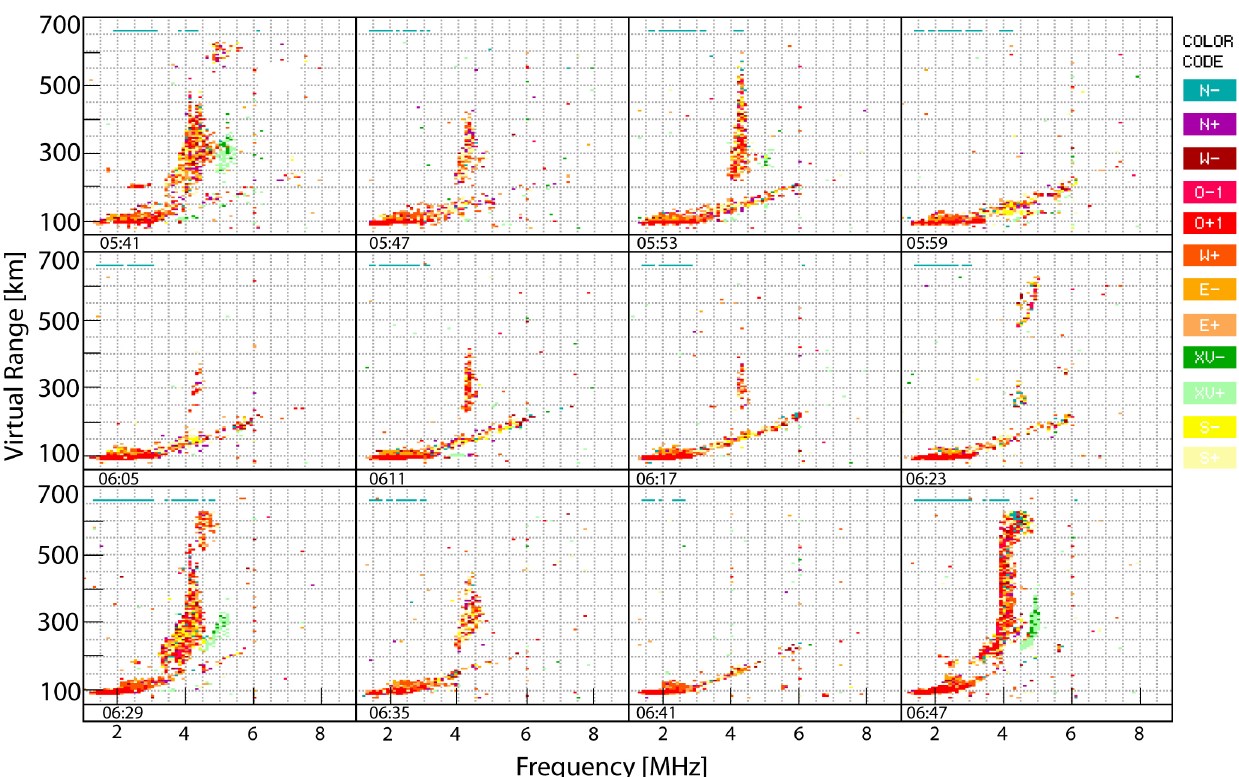
Fig. 5. Multi-beam ionogram records showing the development of a polar cap lacuna and associated slant Es conditions (SEC), starting at 05:41 UT and lasting over 1h on 15 December 1994. Each ionogram ranges from 1 to 8MHz in 100kHz steps. Color-coded and optically weighted fonts provide coarse angle-of-arrival and Doppler information. All cardinal directions are expressed in a compass-oriented coordinate system. At each sounding frequency, a coherent integration of 128 phase-coded pulses at 200-Hz PRF for multiplexed O- and X-modes is performed separately on the system four receiver antennas.